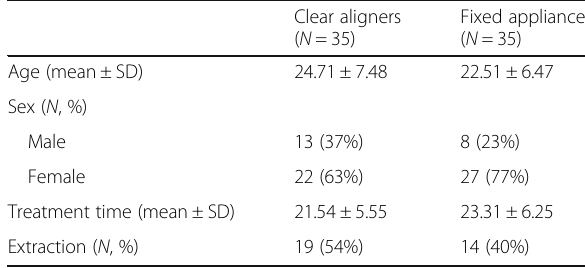
Table 1 Baseline characteristics of participants in the two